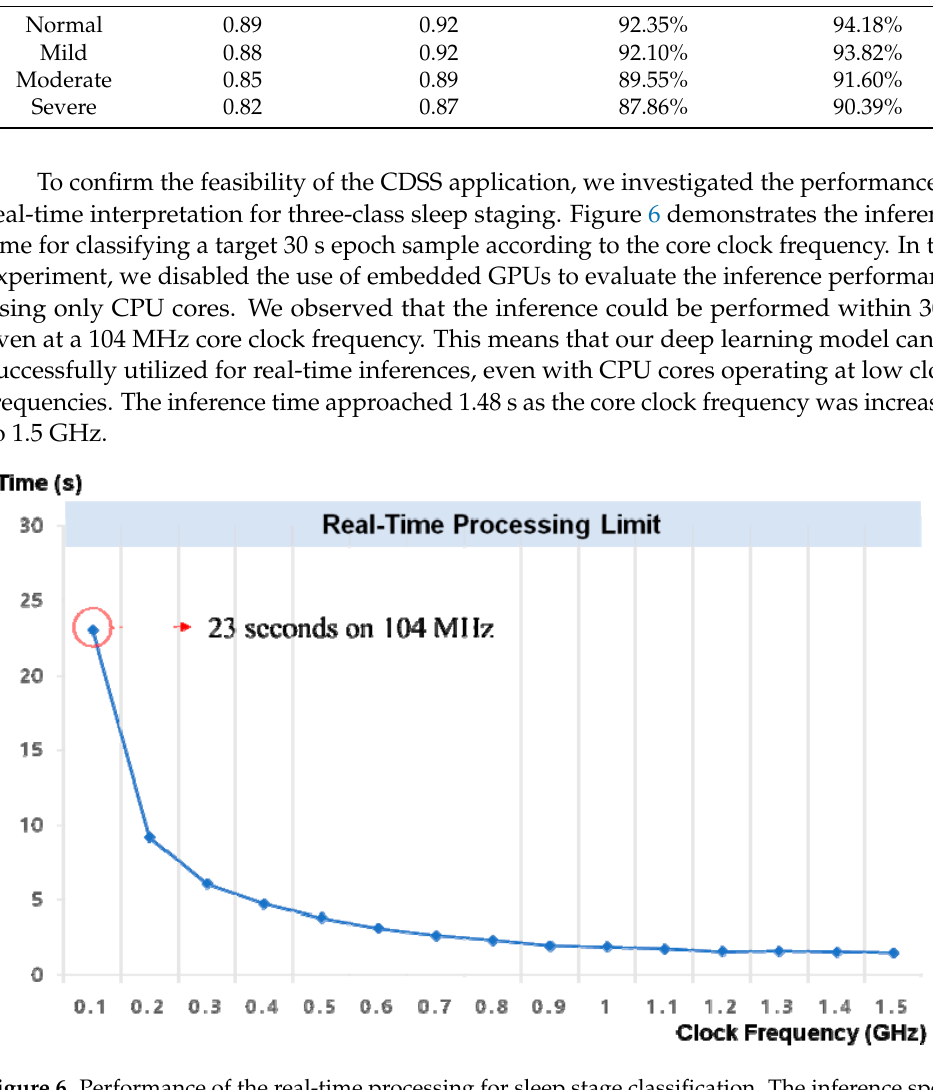
Table 4. Performance of deep learning model based on the severity of obstructive sleep apnea.